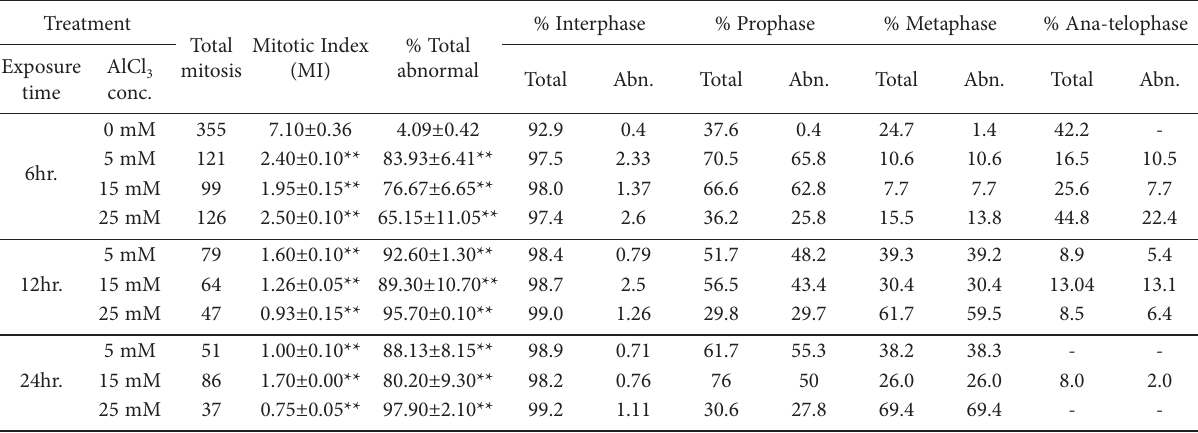
Table 2. Mitotic index (MI), % of total abnormalities, % of interphase and % of mitotic phases (prophase, metaphase and ana-telophase), include normal (Total) and abnormal (Abn) mitotic phases recorded for Vicia faba (Misr 3) root tips under the influence of different con- centrations of AlCl 3 (5, 15 and 25 mM) and exposure times (6, 12 and 24 hr). Treatment